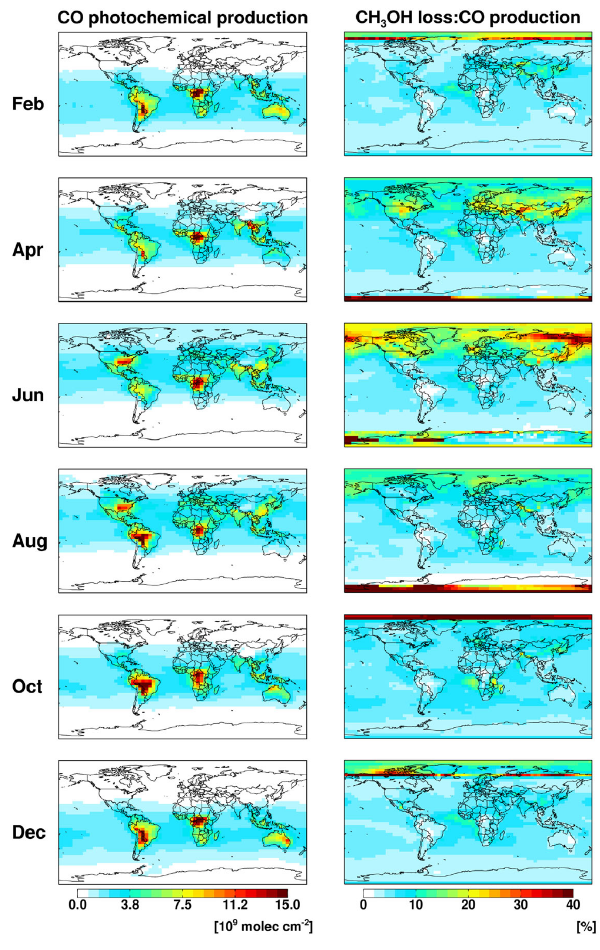
Fig. 13. Importance of methanol as a photochemical precursor of CO and HCHO. Left column: column-integrated photochem- ical production of CO. Right column: percent contribution from methanol oxidation in the GEOS-Chem a posteriori simulation for February, April, June, August, October, and December 2008. The fractional contribution to HCHO production is similar, since almost all photochemical production of CO goes through